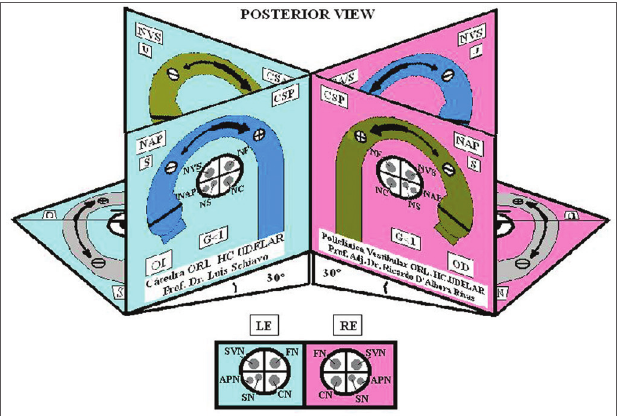
Figure 6. Posterior Face - Acronyms of figures 1,2,4 and 5: A / SSC: Anterior/ Superior Semicircular Canal, PSC: Posterior Semicircular Canal, H/LSC: Horizontal / Lateral Semicircular Canal, SVN: Superior Vestibular Nerve, APN: Posterior Ampullar Nerve, SN: Sacular Nerve, FN/VII: Facial Nerve. CN: Cochlear Nerve, U: Utricle. It shares its in- nervation and vascular supply with this canal, S: Saccule. It shares its vascular supply and innervation with this canal (in this particular case the Sacular Nerve) G: Gain: Ratio between the angular movement of the head and angular movement of the eye. D: Duration / Total length of otoconial migration. L: Latency, which is the time from the final position of the diagnostic Dix-Hallpike maneuver until the appearance of the first nystagmic beat. tNy: Corresponds to the total time of dura- tion of nystagmus, RE: Right Ear, LE: Left Ear, AICA: Anterior Inferior Cerebellar Artery, IAA: Inner Auditory Artery, AVA: Anterior Vestibular Artery, CCA: Common Cochlear Artery, PCA: Posterior Cochlear Artery, CVA: Cochlear Vestibular Artery, CB: Cochlear Branch, RV: Vestibular Branch, sPCA: Similar to the Posterior Cochlear Artery , sCVA: Similar to the Cochlear Vestibular Artery, sAVA, Similar to the Anterior Vestibular Artery. ACV: Aqueduct Cochlear Vein, AVV: Aqueduct Vestibular